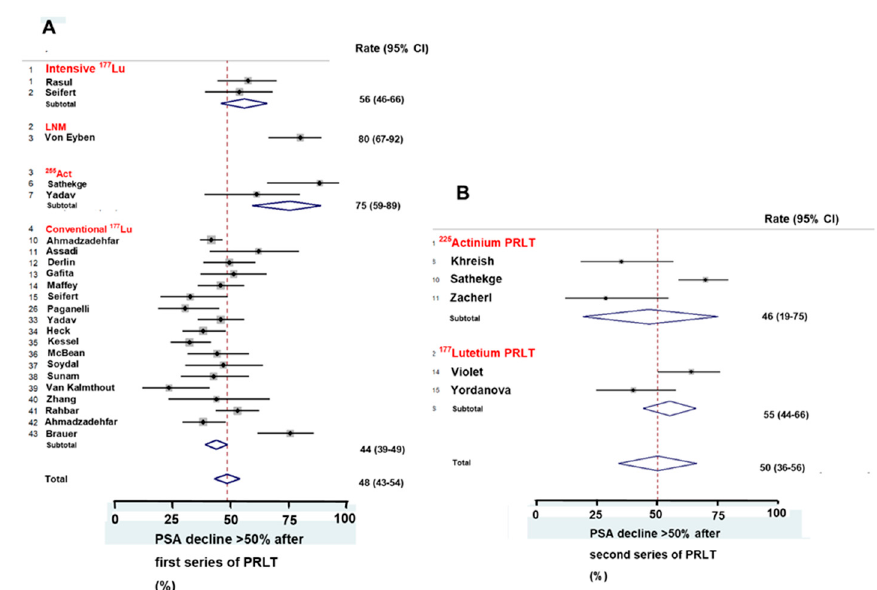
Figure 3. Forest plots show the rate of PSA decline ≥ 50% following two series of PRLT (PSMA based radioligand therapy) using either 225 Act or 177 Lu as radionuclide. The rate of PSA decline ≥ 50%was grossly similar after the first series of PRLT ( A ) and after the second series of PRLT ( B